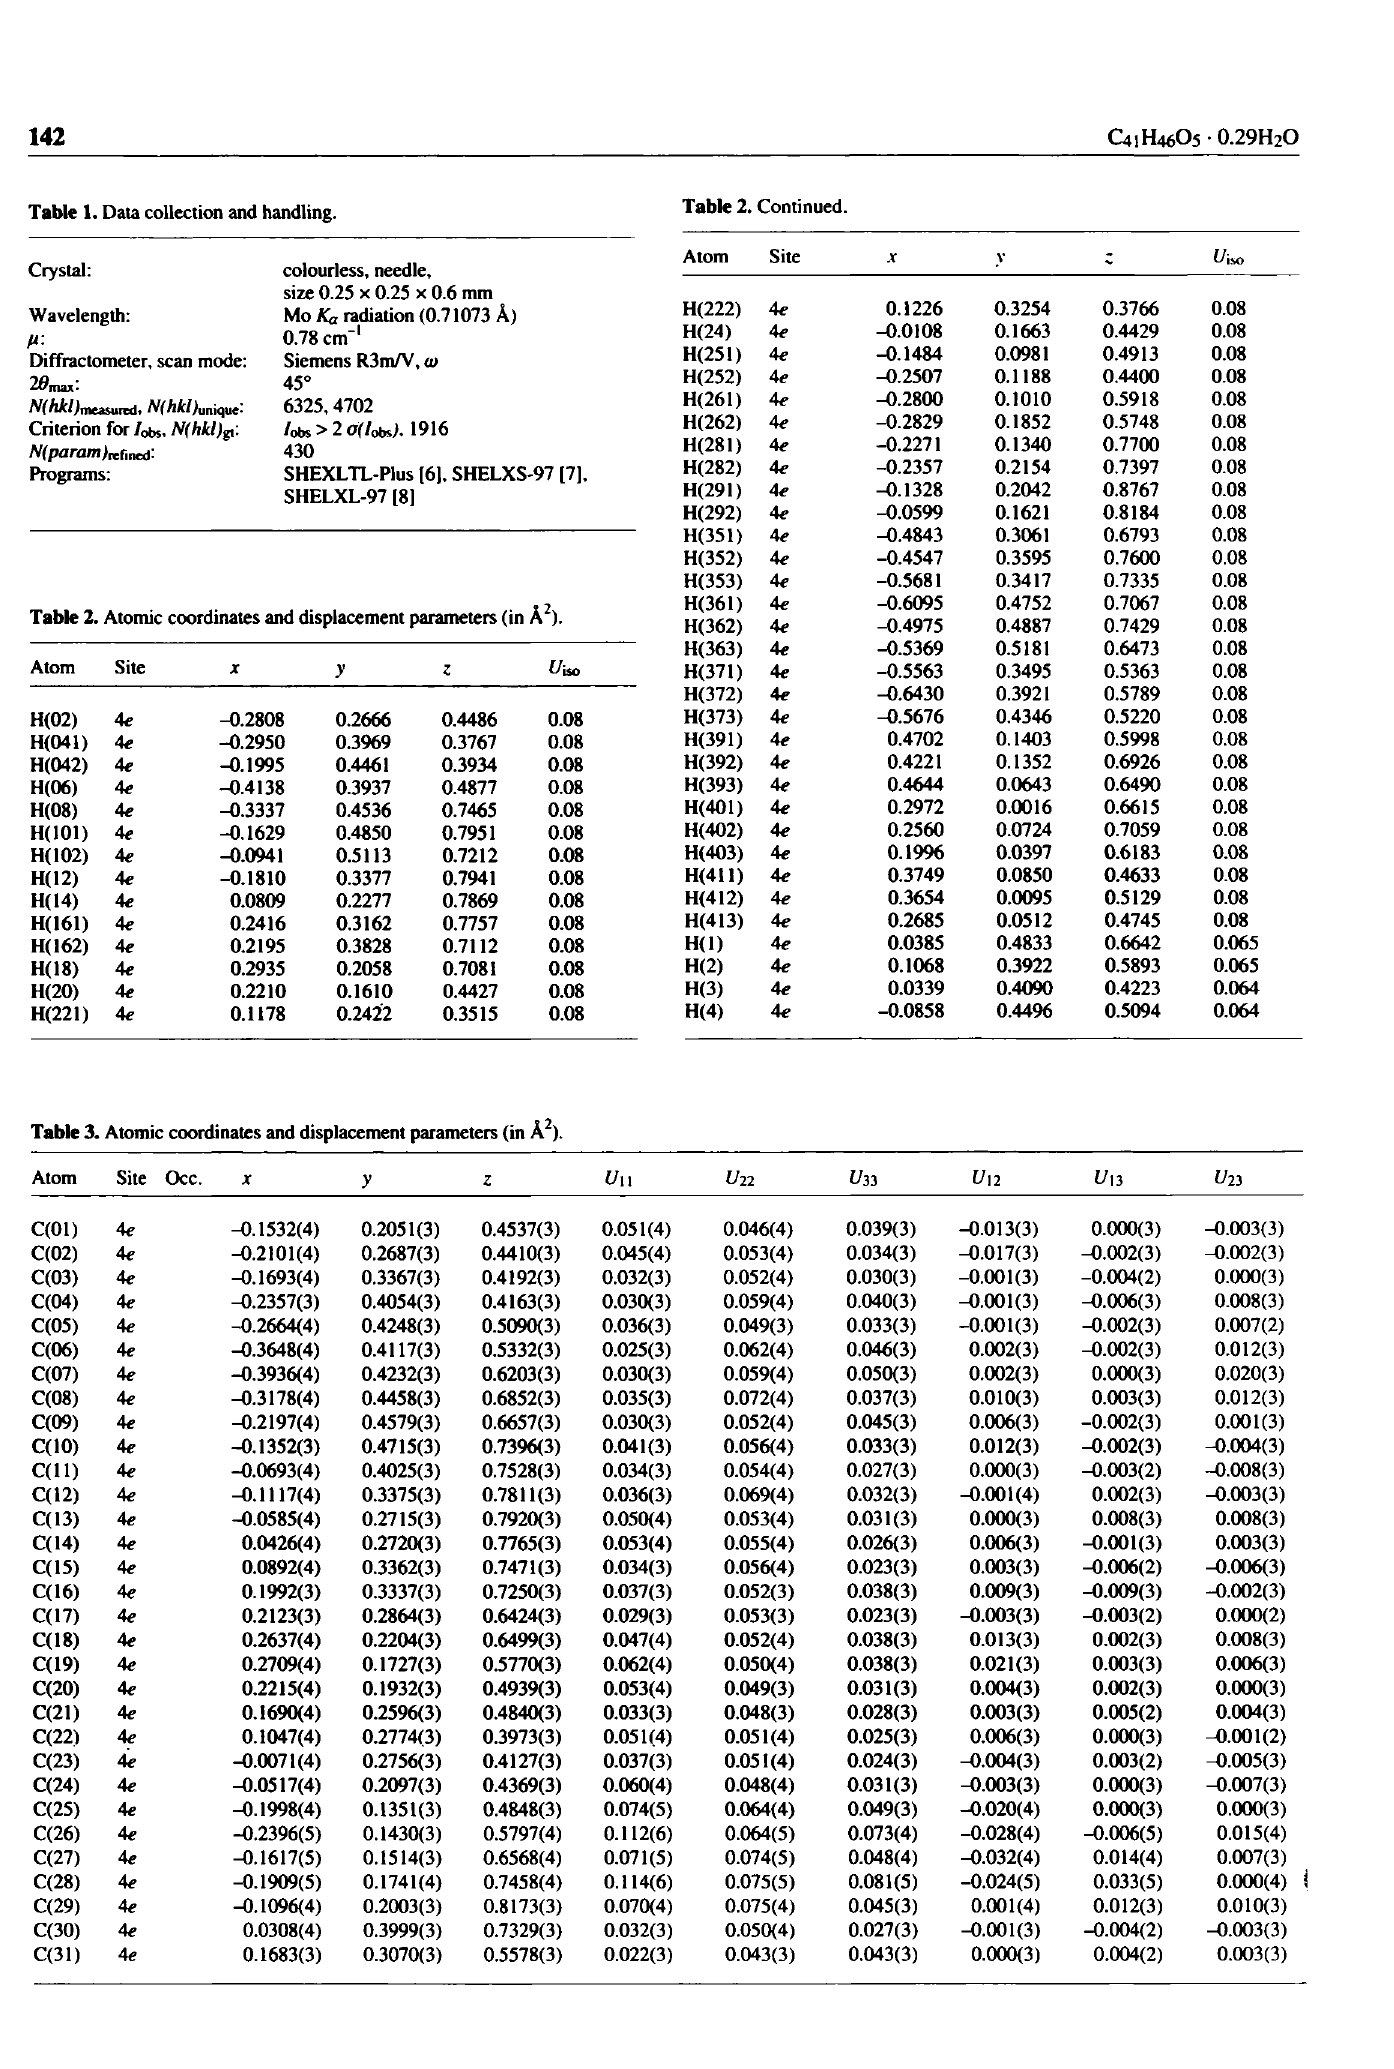
Table 3. Atomic coordinates and displacement parameters (in Ä 2